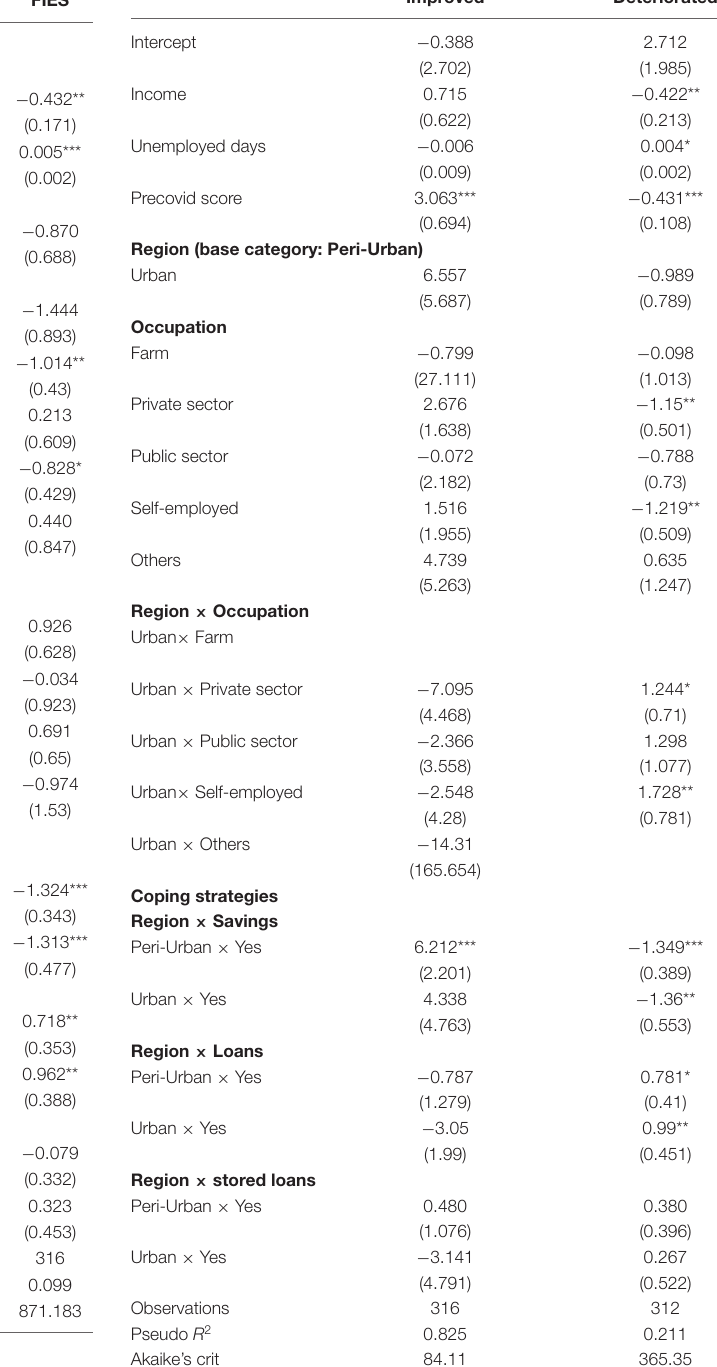
TABLE 4 | Dynamics of household food insecurity ‘as assessedin terms of FIES